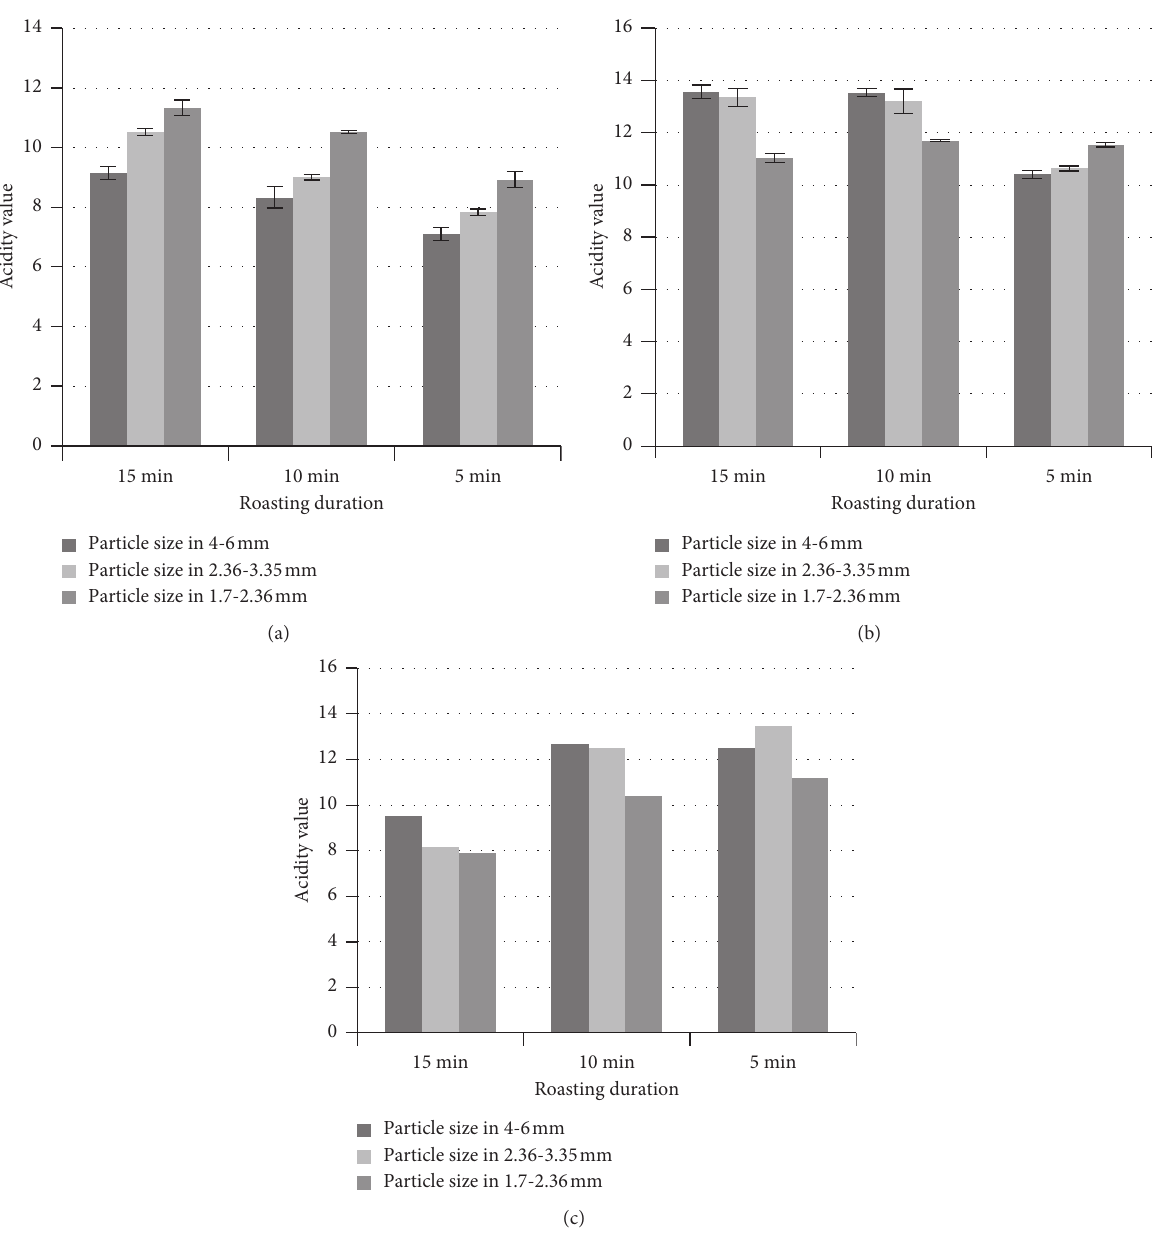
Figure 5: Effect of coffee bean particle size, roasting temperature, and roasting time on the acidity value of the coffee beverage. (a) Roasting temperature at 200 ° C. (b) Roasting temperature at 230 ° C. (c) Roasting temperature at 260 °